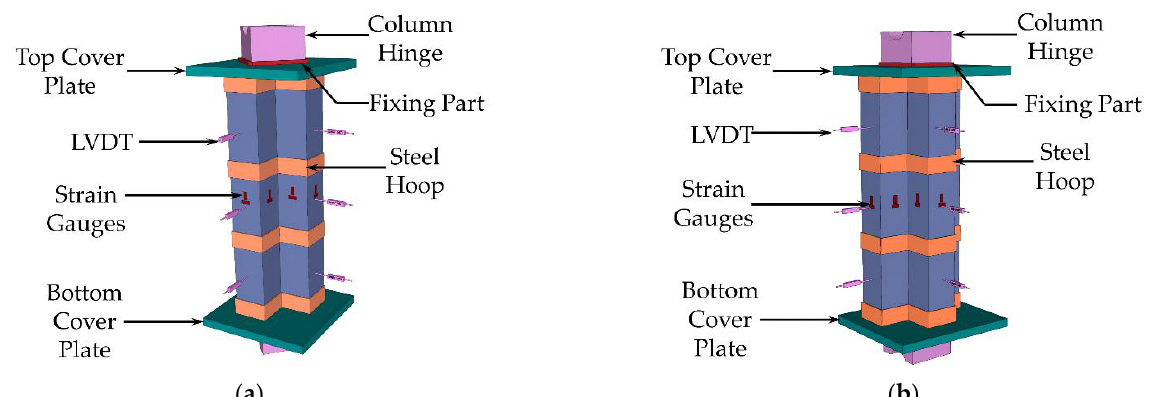
Figure 7. Layouts of the measuring device ( a ) L-shaped; ( b ) T-shaped.